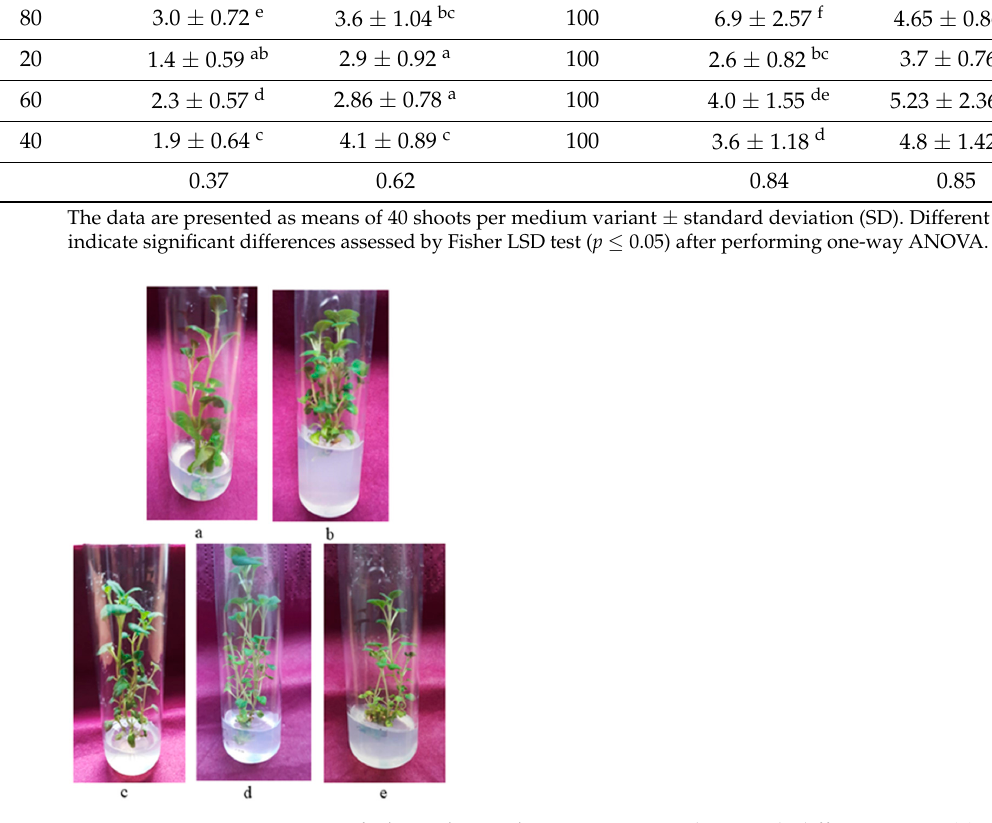
Figure 1 . Micropropagation of Clinopodium vulgare L. on MS medium with di ff erent PGRs: ( a ) con- trol MS medium, ( b ) B1, ( c ) Z1, ( d ) K1 and ( e )